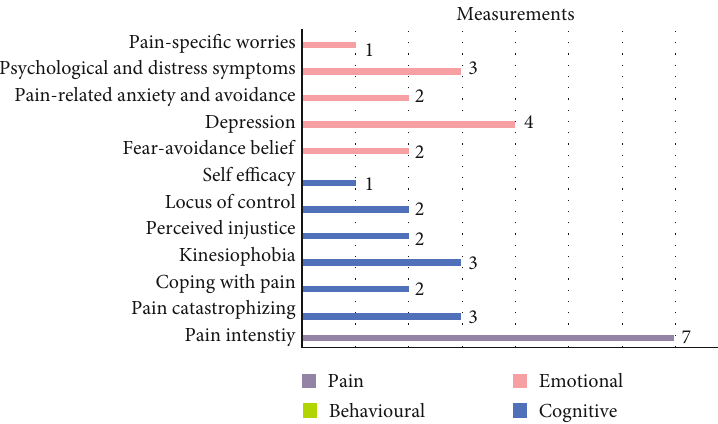
Figure 4: Frequency of the measurements area based on psychological aspect of pain.